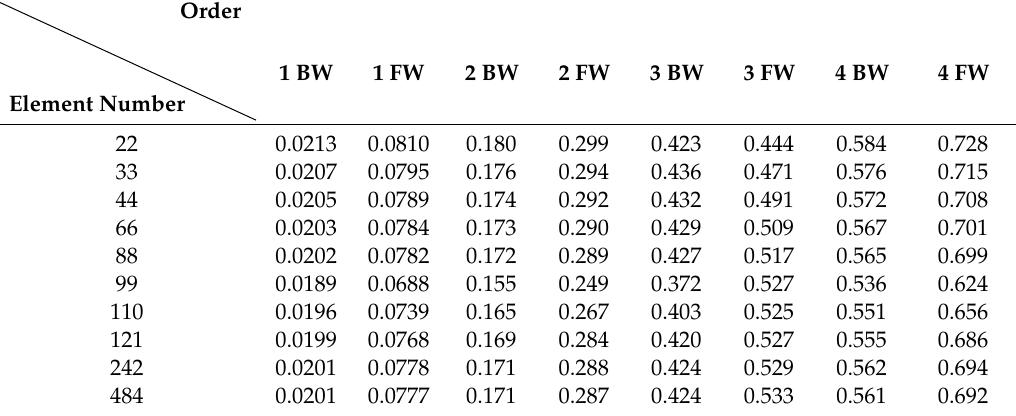
Table 11. Natural frequencies via spatial discretization ( h = 200 Nms).